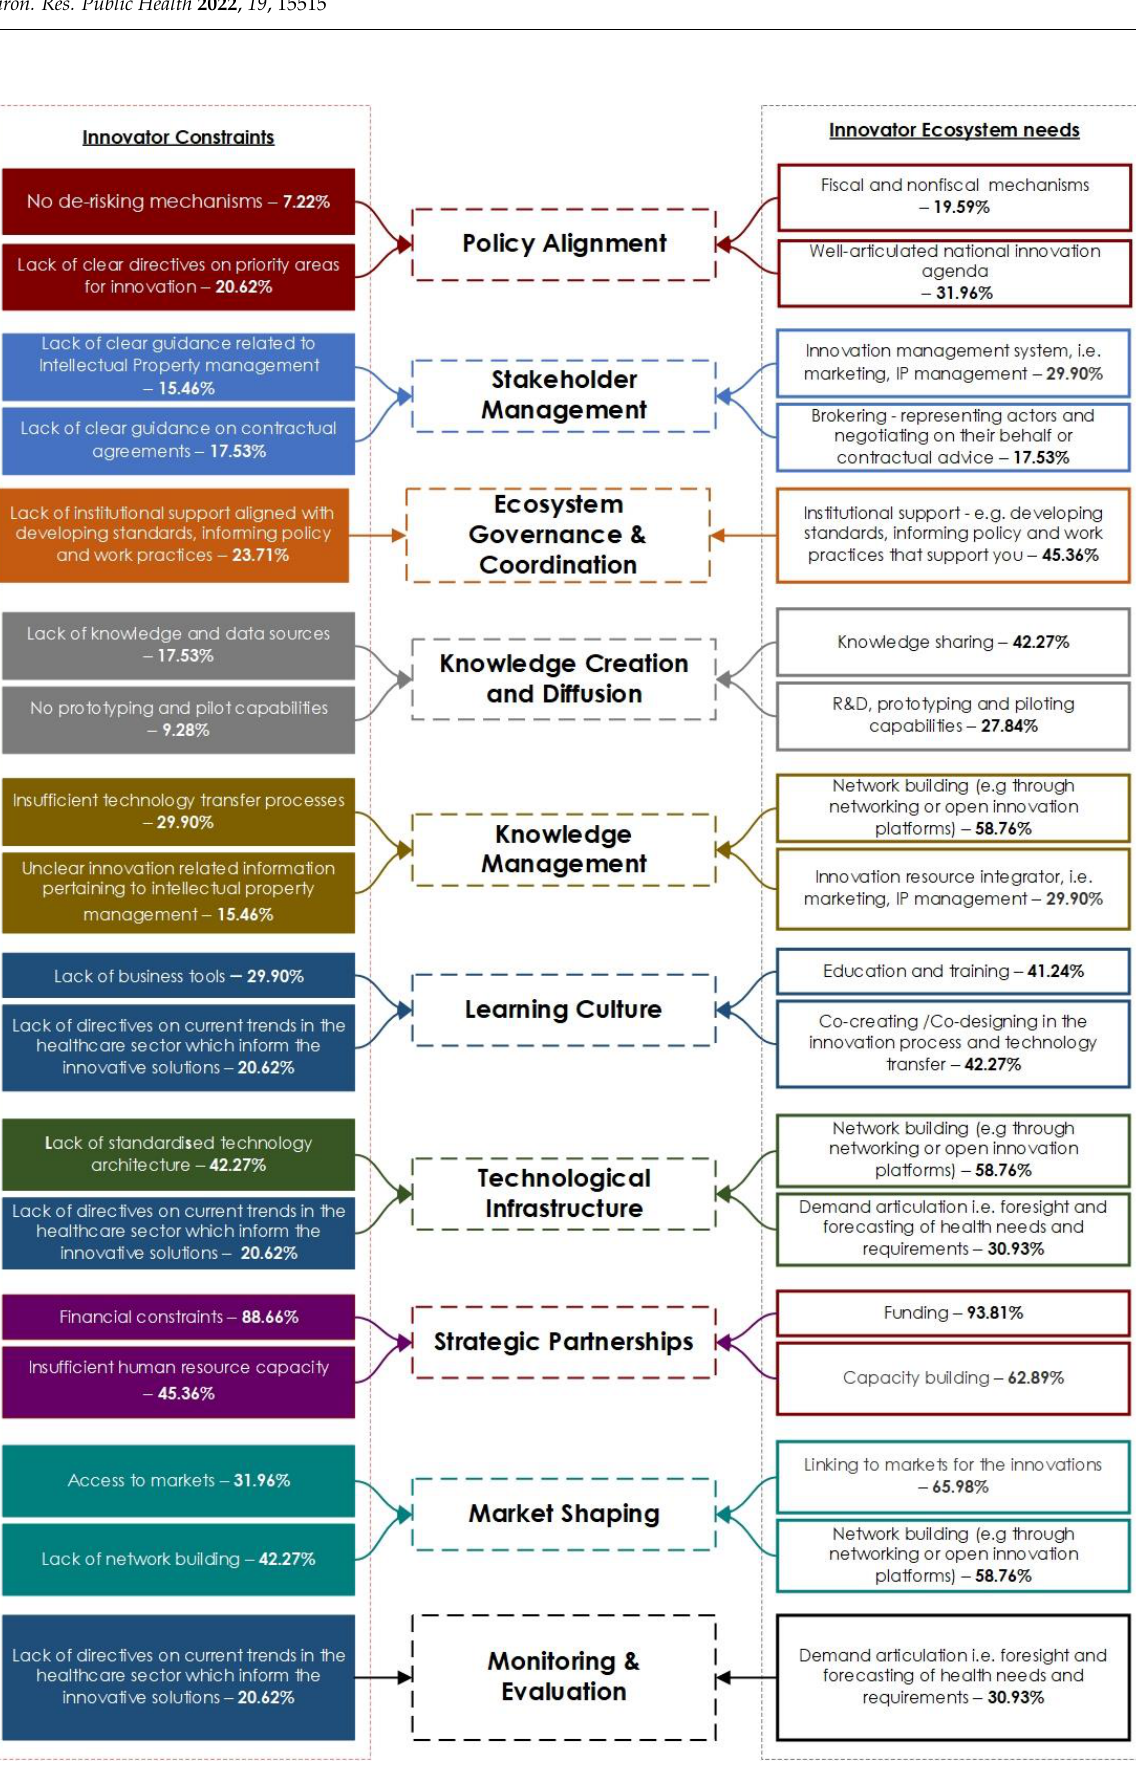
Figure 3. Ecosystem framework foundational pillars. These pillars were derived from the survey responses as key recurring themes and what they mean for the ecosystem.